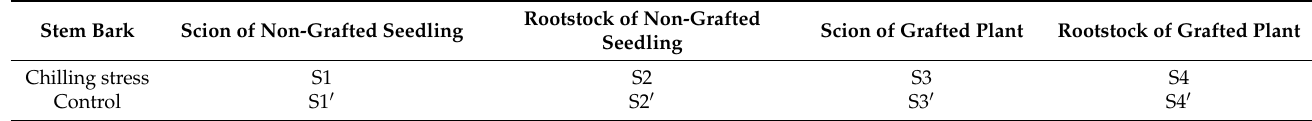
Table 1. Two groups of stem bark samples and their serial numbers.